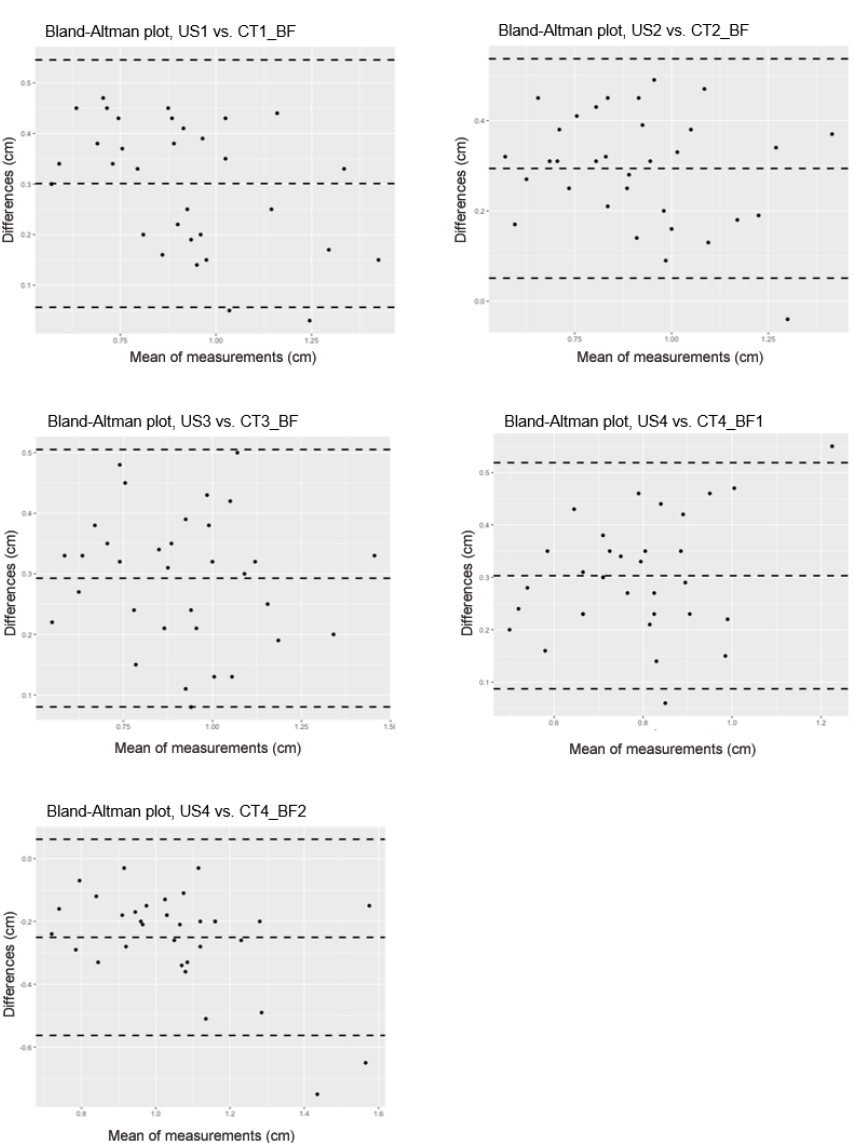
Figure 5. Bland–Altman analysis comparing two methods for measuring back-fat thickness in carp: the ultrasound method (US) and the CT-based method (CT_BF); n = 33. Differences are calculated as US − CT, middle dashed line: mean value of the difference, upper and lower dashed lines: standard deviation of the